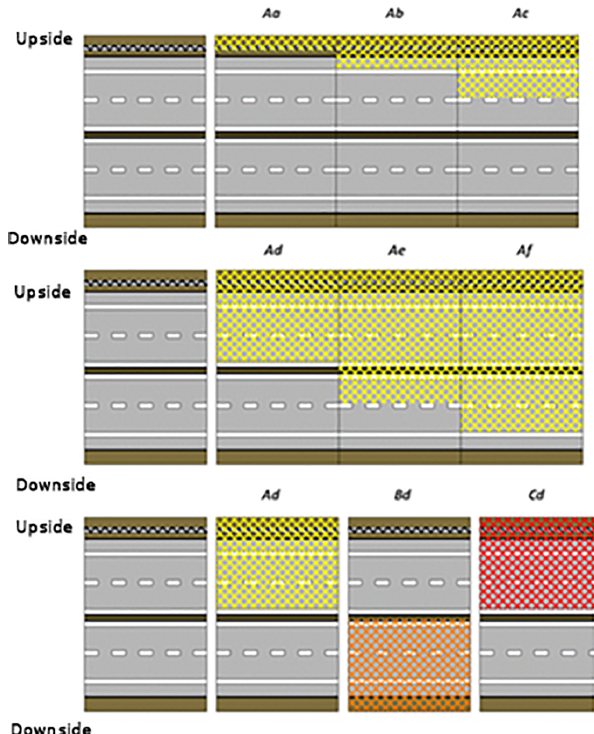
Figure 6. Top and middle: possible risk scenarios involving sce- nario A (landslides that could reduce friction) to increasing sec- tors of the highway. Bottom: combinations of scenarios with several types of phenomena that affect the emergency lane, regular lane and fast